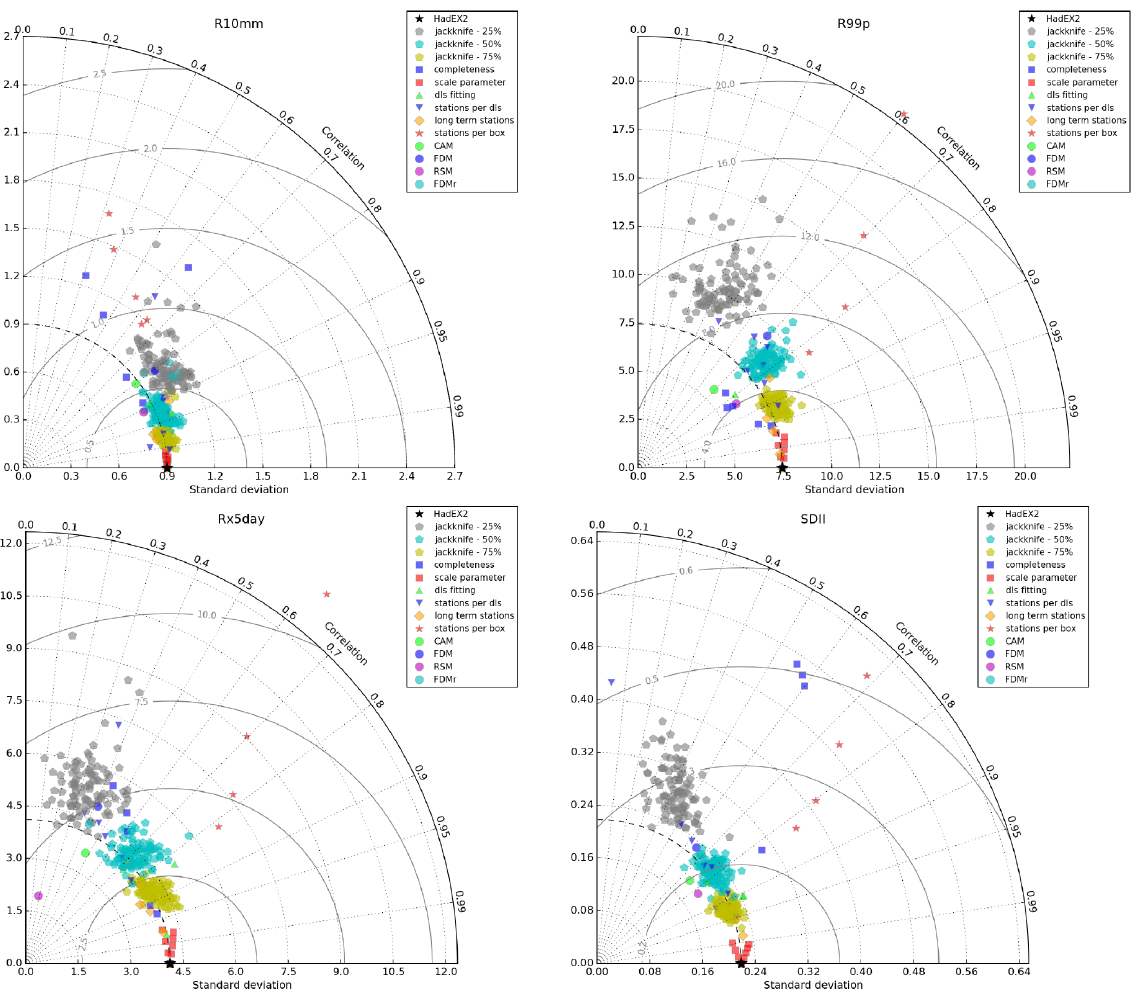
Figure 20. Continued. Diagrams for R10mm (Number of days with precipitation > 10mm), R99p (annual sum of daily precipitation > 99